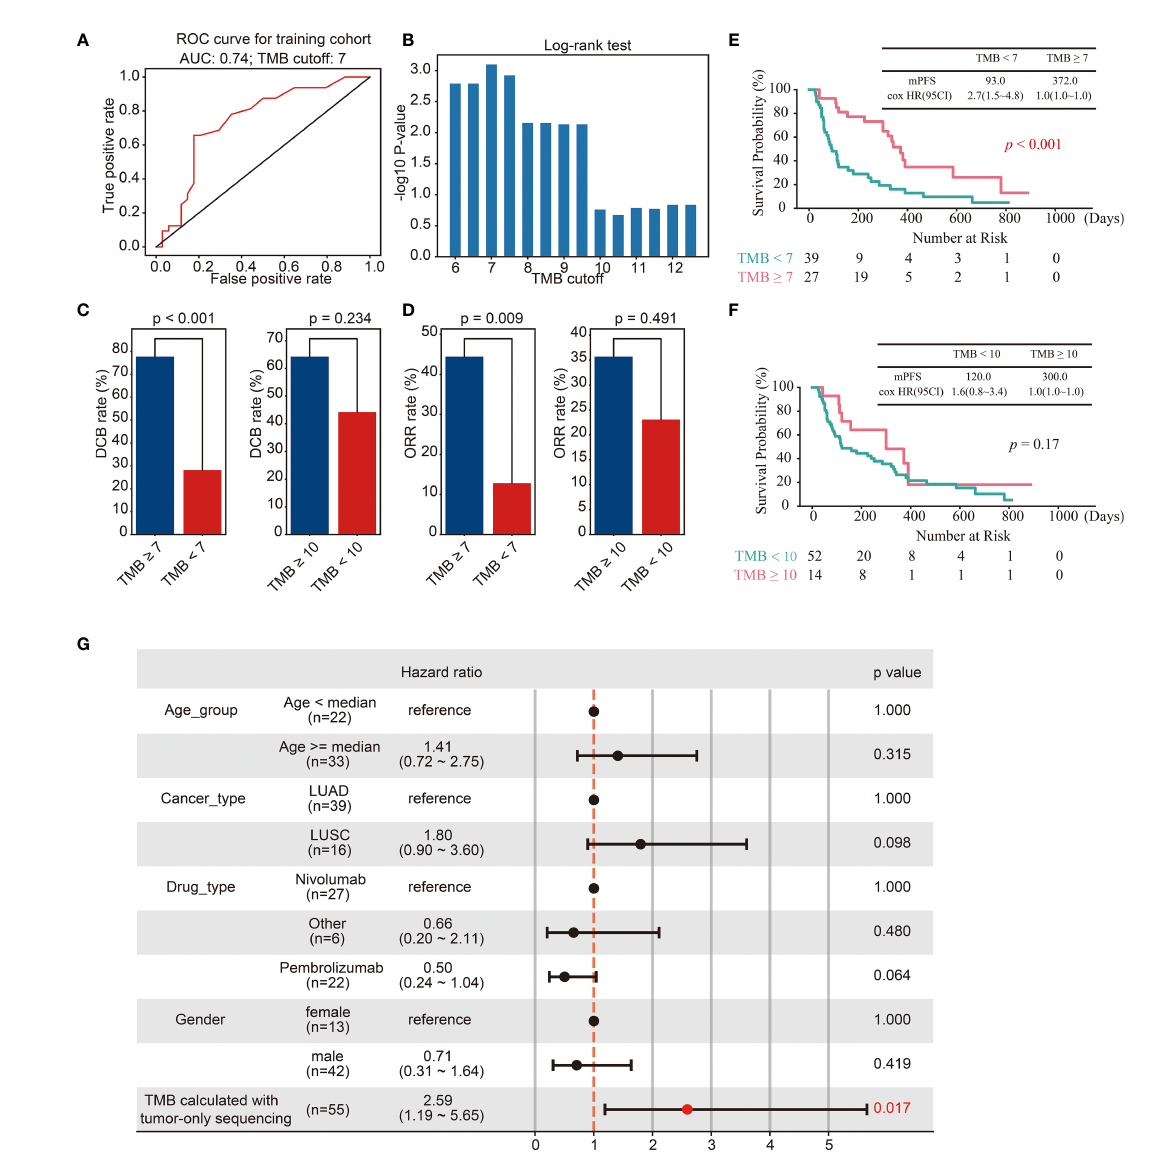
FIGURE 4 Identi fi cation of the cut-off of TMB for predicting immunotherapy ef fi cacy in the training cohort. (A, B) ROC curves (A) and Log-rank test (B) for the identi fi cation of the TMB cut-off. (C, D) Barplots of DCB rate (C) and ORR rate (D) between different groups of TMB cut off 7 and 10. (E) Kaplan – Meier curves of OS comparing TMB ≥ 7 group and TMB< 7 group. (F) Kaplan – Meier curves of OS comparing TMB ≥ 10 group and TMB< 10 group. (G) The multivariate Cox regression analyses of the TMB, gender, age, drug, and cancer